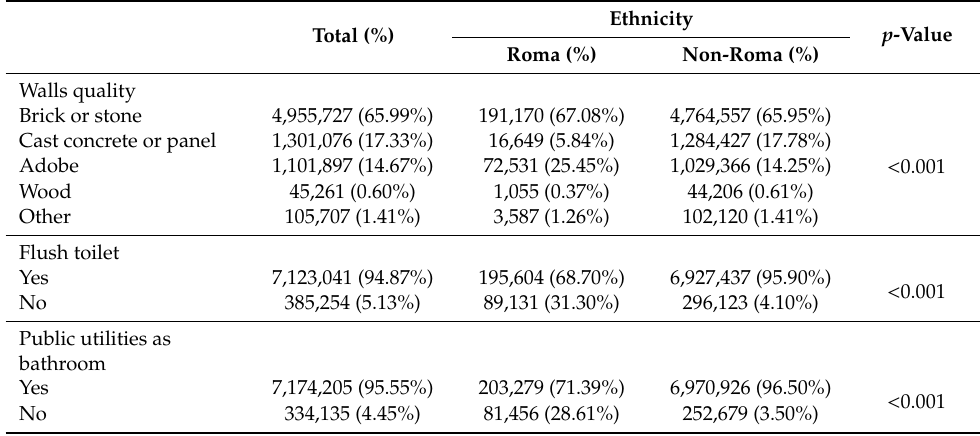
Table A1. Housing conditions and personal characteristics of the study population and the di ff erences between the Roma and non-Roma populations, evaluated by χ 2